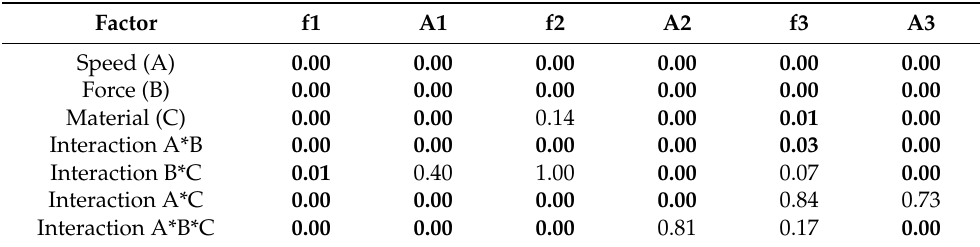
Table 7. ANOVA analyses for the axial forces, test IDN 020. In bold the p -values lower than 0.05, selected as significance threshold, are evidenced.